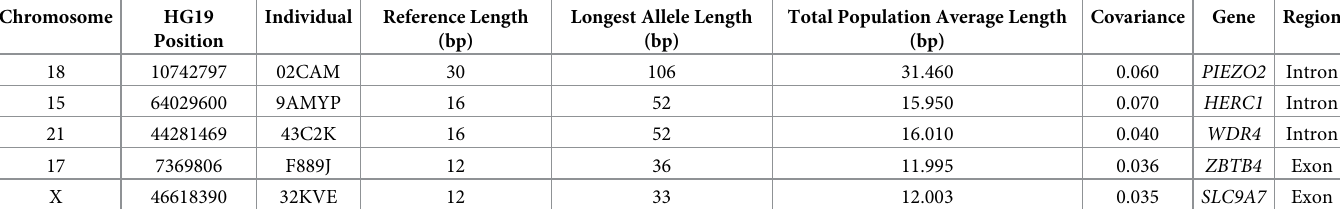
Table 4. Individuals with divergent STR lengths in conserved regions of